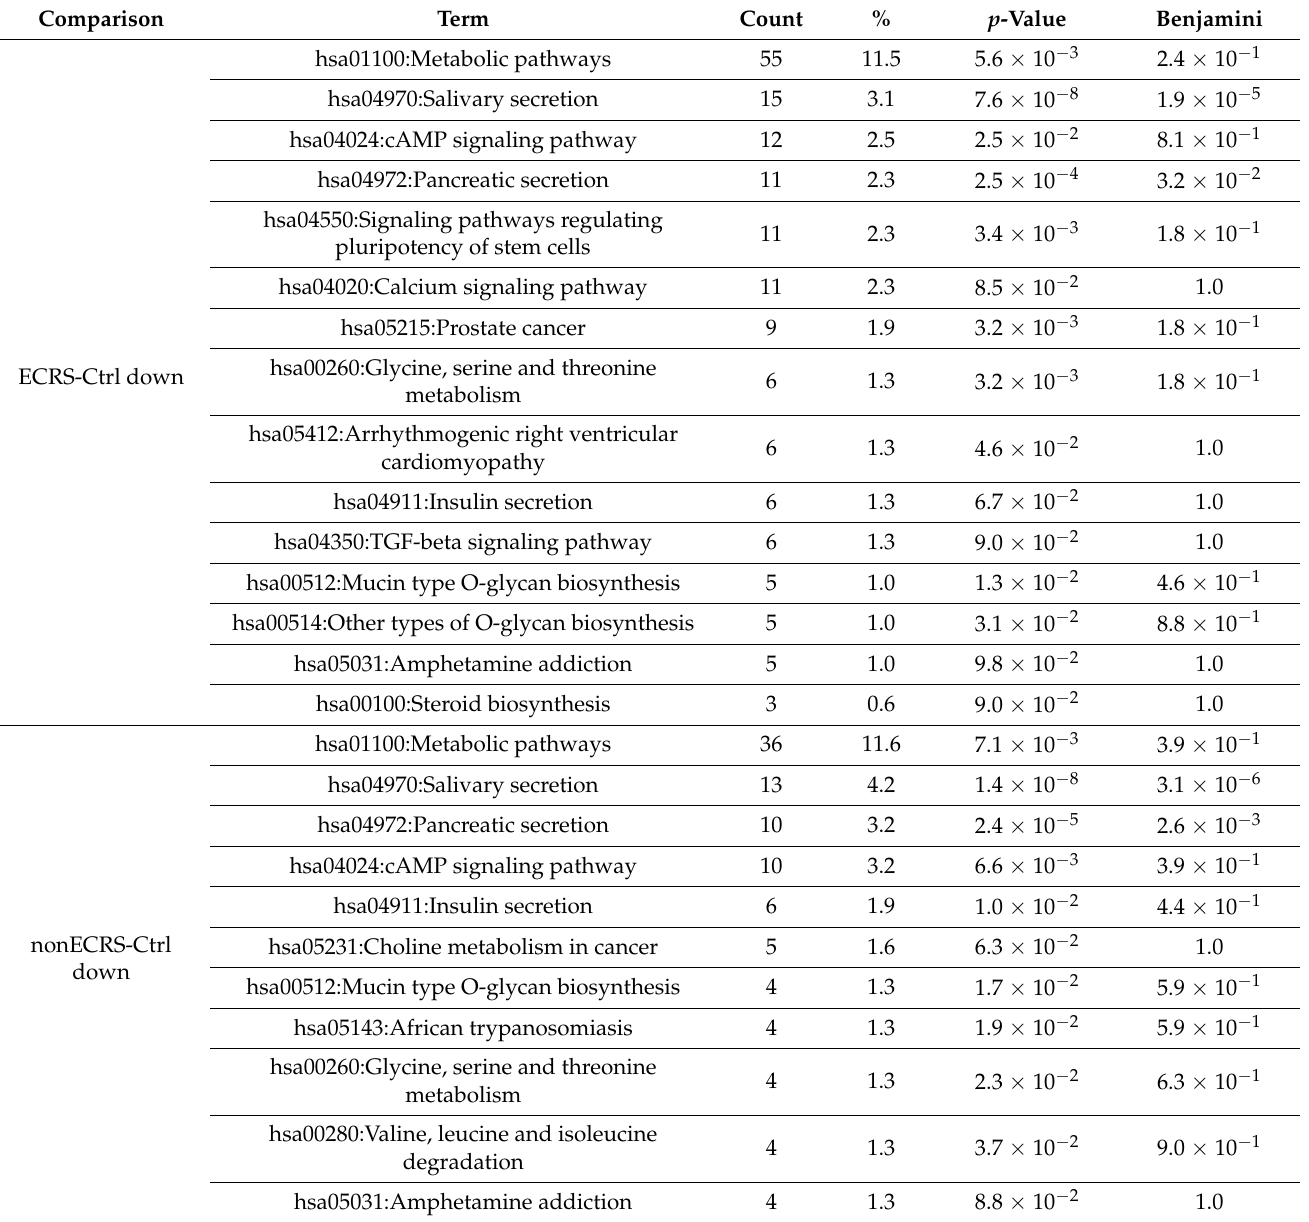
Table 3. KEGG pathways using the downregulated DEGs into the DAVID. Genes associated with “metabolic pathways”, “salivary secretion”, “mucin type O-glycan biosynthesis”, and “glycine, serine and threonine metabolism” were commonly downregulated. The gene count for “metabolic pathways” was the highest among all the CRSwNP groups vs control, and the gene counts were widely distributed as ECRS-Ctrl of 55, nonECRS-Ctrl of 36, and Asp-Ctrl of